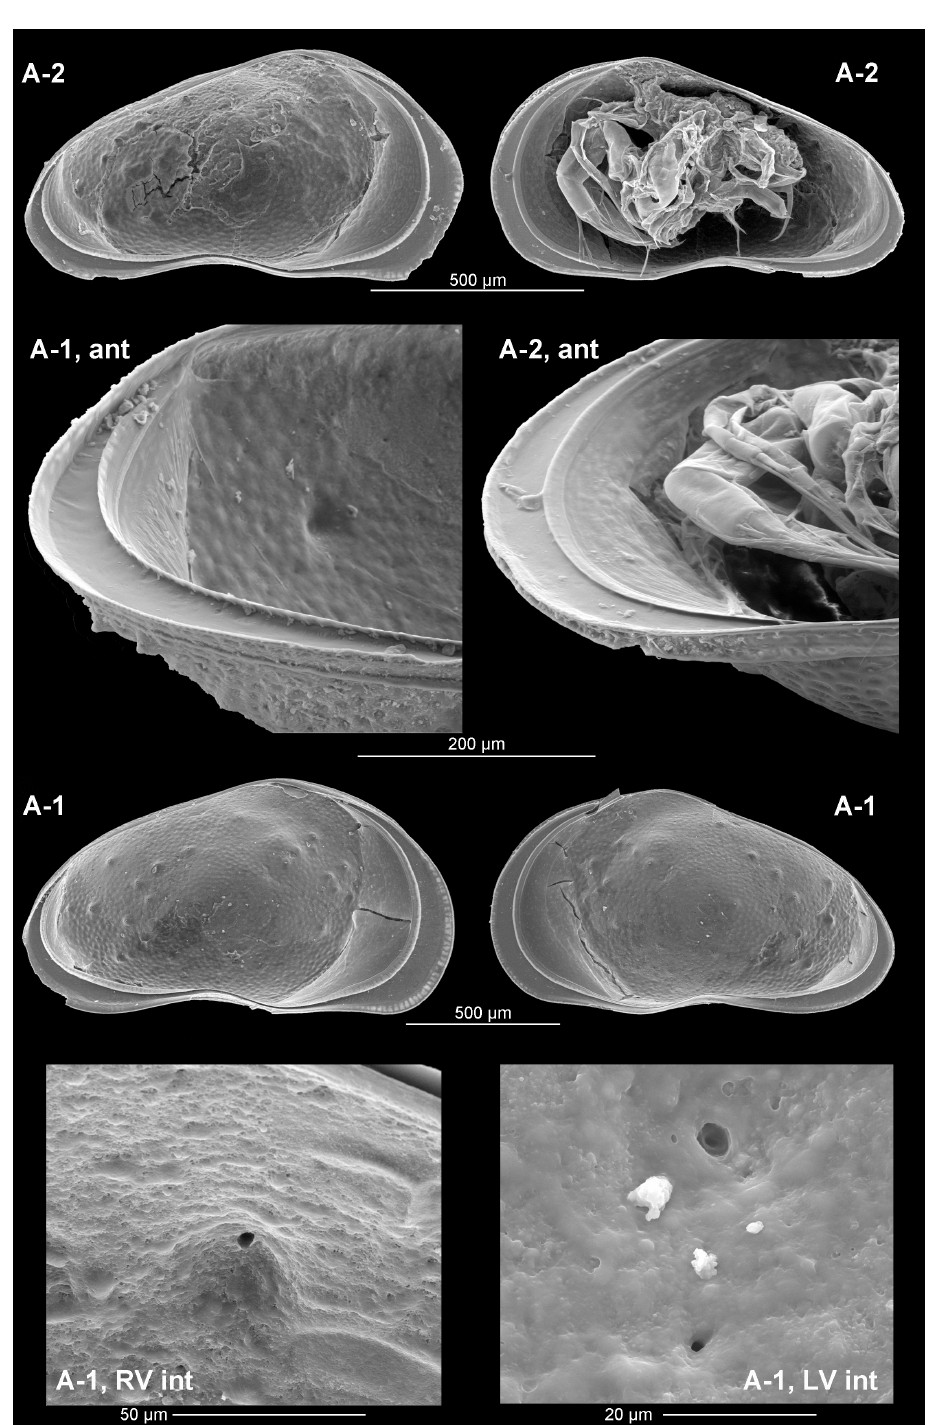
Fig. 24. Internal views of juvenile specimens of Bennelongia gwelupensis . Top row . internal views of A-2 juveniles from Arro Swamp (LV on left and RV on right with appendages). Second row . details of internal views of anterior RV (tilted) of A-1 specimen from Katanning Road pool on left, and A-2 on right which is the same specimen as the image above, but tilted. Third row . internal views of A-1 juveniles from Katanning Road pool (LV on left and RV on right); same specimen as detail left above. Bottom row .detail of internal views of RV on left and of LV on right; both are the same A-1 specimens as the images above, to show that the pores on the cones connect with the inside of the